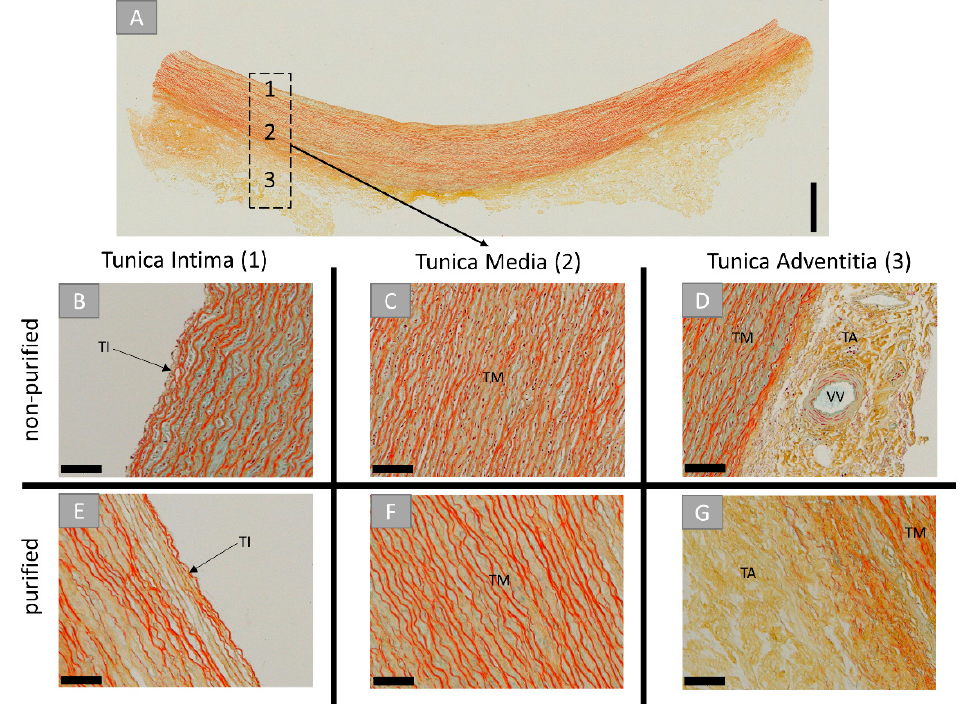
Figure 1. ( A ) Cross-sectional overview and detail microscopic images prior ( B – D ) and after decellularization ( E – G ) of the porcine aorta. TI: tunica intima, TM: tunica media, TA: tunica adventitia, VV: vasa vasorum. (Movat pentachrome stainings, ( A ) “total scan”, scalebar = 1 mm, ( B – F ) 20× magnifications, scale bars = 100 µm).